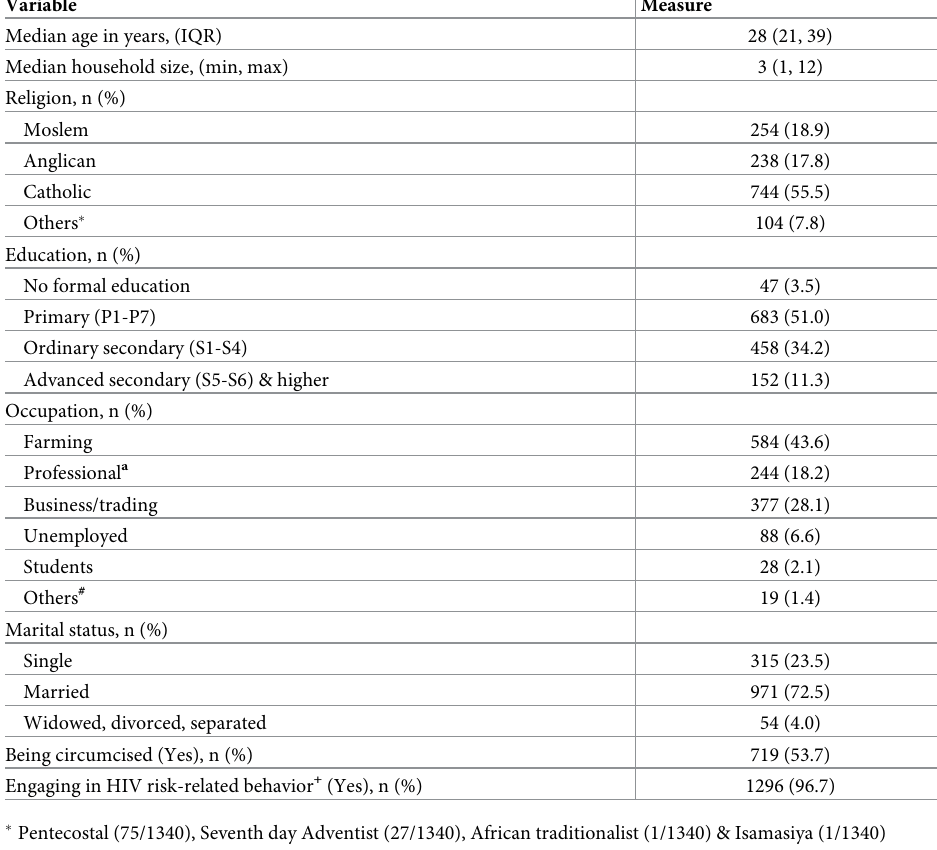
Table 1. Socio-demographic and behavioral characteristics of survey participants from selected villages in Mpigi district, August to September 2018 (N =